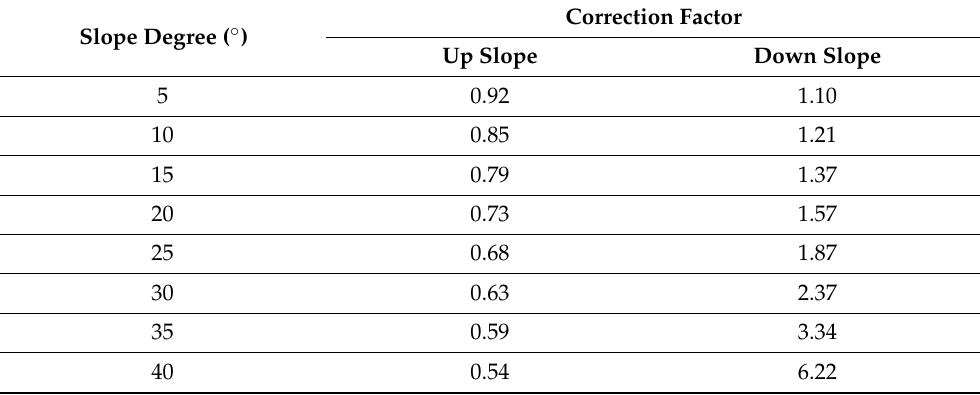
Table 2. Correction factors for applying a seed dispersal distance which is predicted on flat terrain into that on up or down slope. Slope Degree ( ◦ )